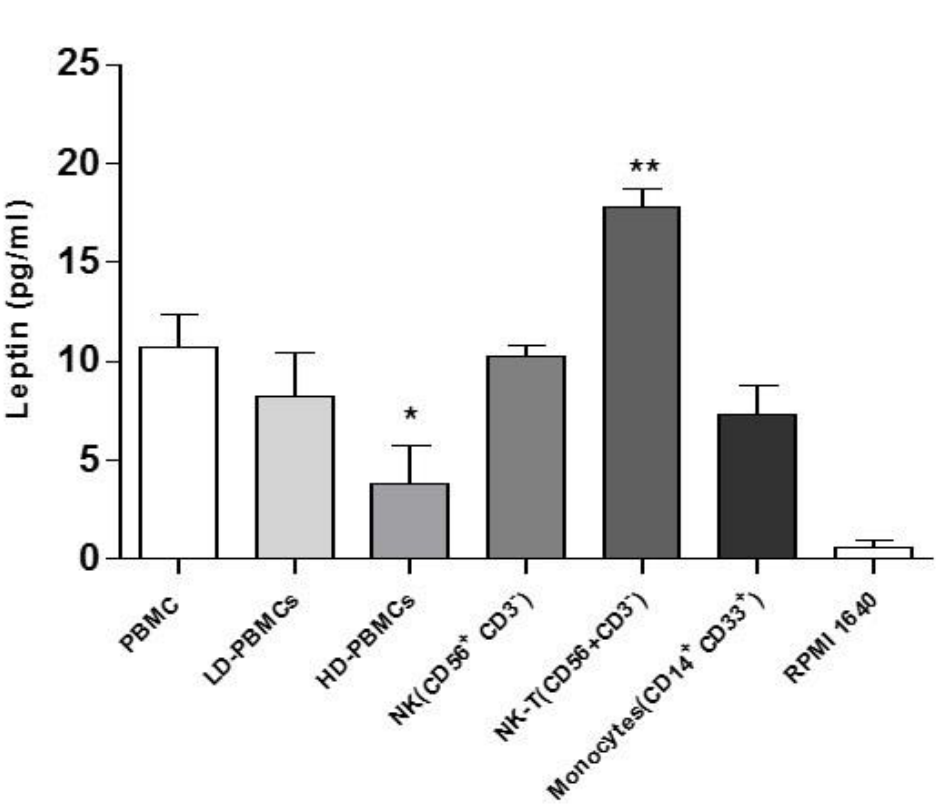
Figure 2. PBMCs basal leptin secretion has been evaluated by ELISA assay. Total PBMCs basal leptin levels were assessed, and no significant variations were observed in LD-PBMCs, NK, and mono- cytes subpopulations compared to total PBMCs. Basal leptin levels in HD-PBMCs were significantly decreased compared to total PBMCs. NK-T basal leptin levels were significantly higher compared to any PBMCs subpopulation. Each subpopulation has been isolated from three healthy donors ’ buffy coat. Data are expressed as mean ± SEM and were analyzed with Wilcoxon – Mann – Whitney U Test (* p = 0.05, ** p < 0.005). PBMC: peripheral blood mononuclear cells; LD-PBMCs: low density